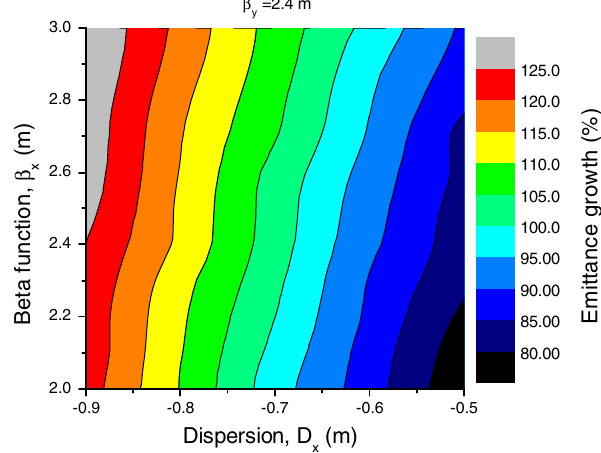
FIG. 7. Color map showing the corresponding horizontal emittance growth after the wedge as a function of the dispersion and beta function. The vertical scale on the right shows the percentage of emittance growth induced by the wedge compared to the no absorber case. All studies assume a single ð C Þ 250 mm thick house-shaped wedge at a 162° angle 2 H 4 n and assume the modified lattice S 2 . The wedge is pointing along the horizontal direction with its apex placed near the beam center.